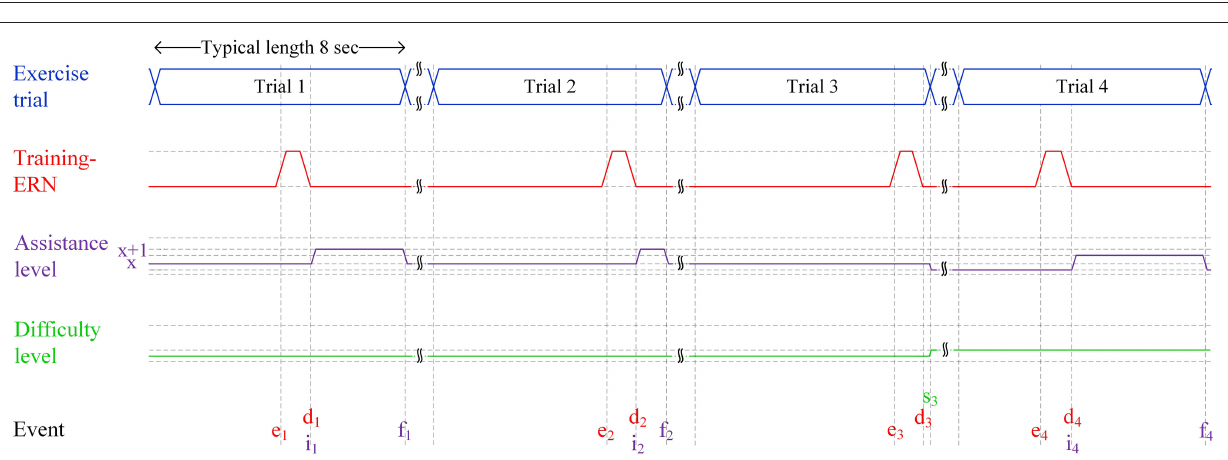
FIGURE 2 | Four typical trials of the ERN-RASRS illustrated using a timing diagram. The durations in the figure are not scaled. Event e marks the time when the ERN associated with the Training-ErrP signal elicits. Event d marks the time when the ERN signal is detected. x shows the minimum level of assistance provided by the rehabilitation robot throughout the exercise trial. The x + 1 shows the level of assistance provided by the rehabilitation robot on the detection of the ERN signal. Event i marks the time when robotic assistance is increased to level x + 1 . Event f marks the time when the current trial finishes and the robotic assistance is decreased to level x . Event s marks an exercise trial in which almost the whole exercise is performed only with the minimum level of robotic assistance (i.e., x ); thus, the difficulty level of the exercise is increased, and the minimum level of robotic assistance (i.e., x ) is